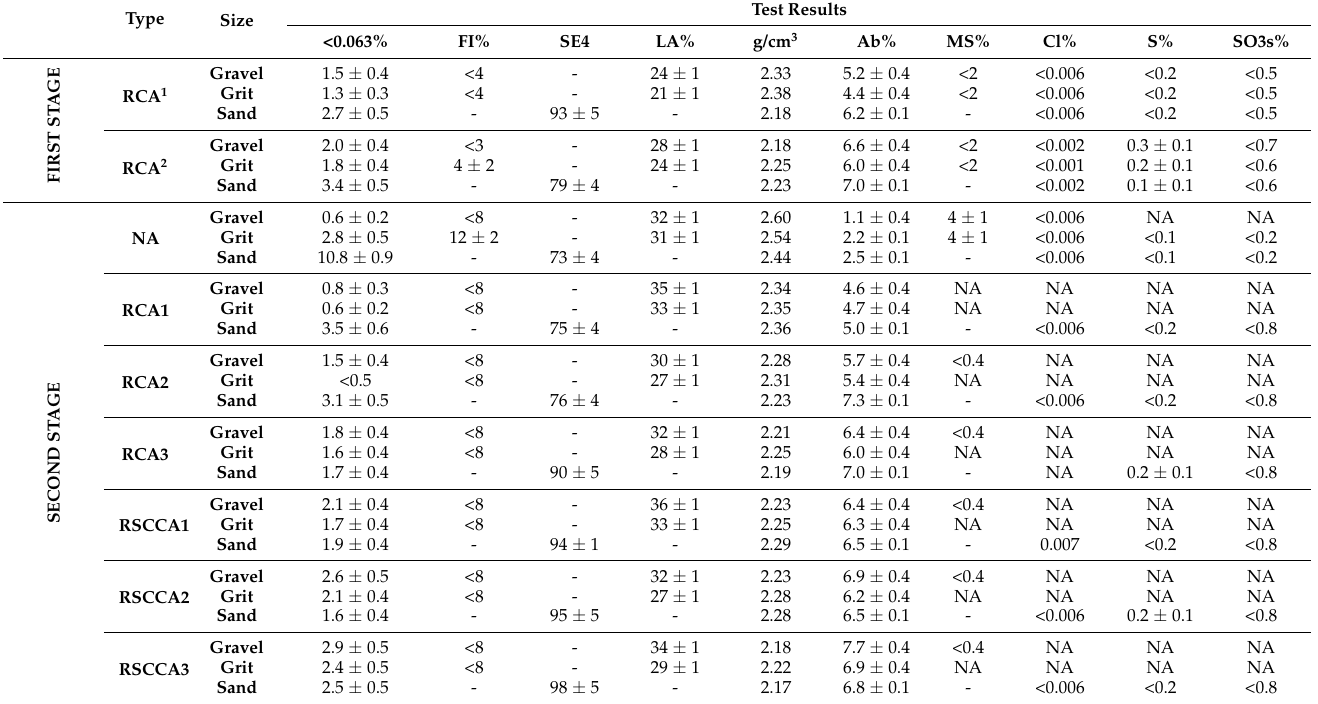
Table 8. Summary of experimental results of performed tests on recycled and multi-recycled concrete